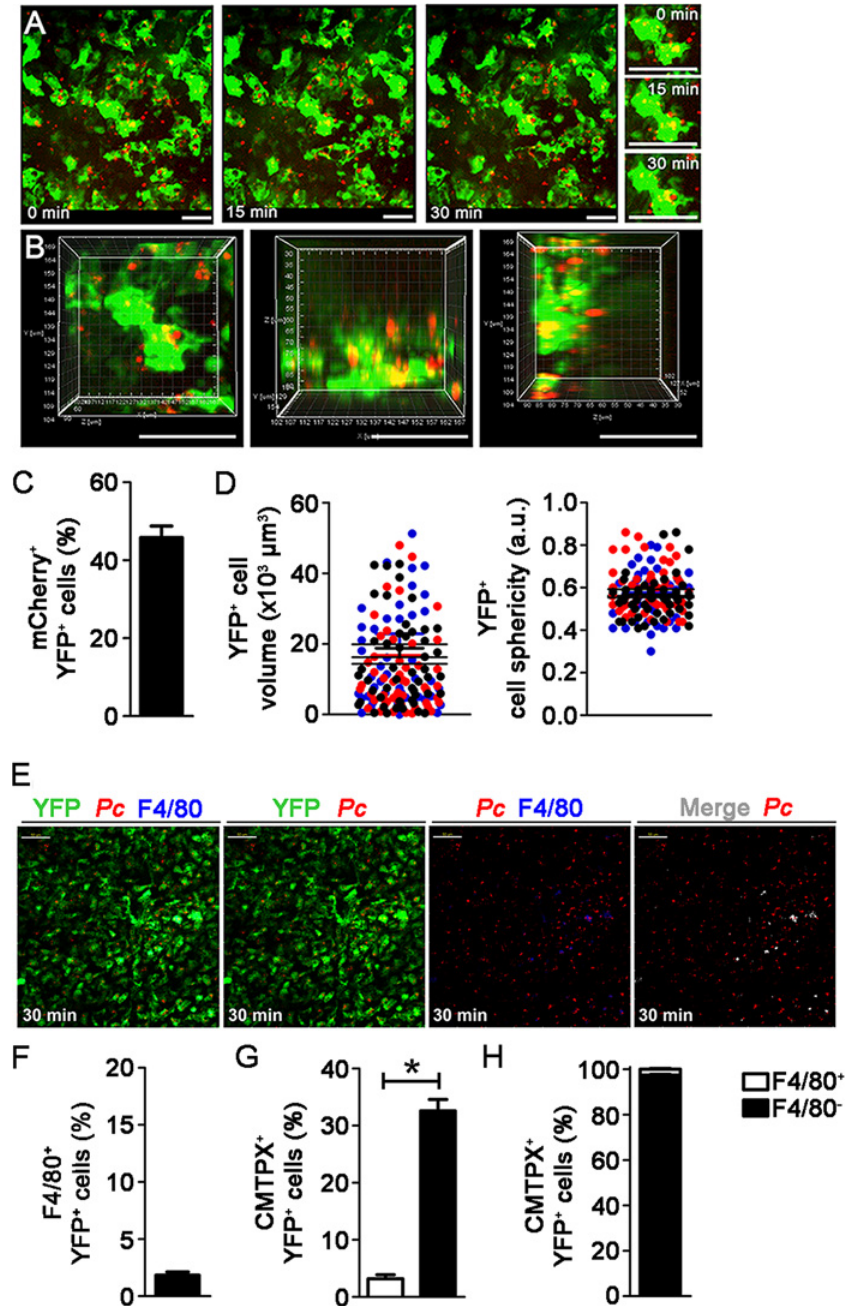
Figure 5. In vivo analysis of iRBC uptake by subcapsular RP DCs during pre-crisis. (A-D) B6.CD11c- YFP mice were i.p. infected with 1 × 10 6 mCherry- Pc iRBCs. Spleens were analyzed by CIVM after five days, at a time of day when mature parasite stages predominated. (A) Serial snapshots show the subcapsular RP and, in the right panel, a detailed image of a YFP + cell (green) upon phagocytosis of an mCherry- Pc iRBC (red). (B) CIVM 3D animation shows the presence of mCherry- Pc iRBC remnants (yellow spots of merged mCherry/YFP-3D signal) inside the YFP + cells. (C) Percentage of mCherry + cells in the YFP + cell population is shown (mean ± SEM). (D) YFP + cell volume and sphericity are shown. Black, red and blue dots are from three different experiments. Horizontal lines represent mean values and SEM. (E - H) B6.CD11c-YFP mice were i.p. infected with 1 × 10 6 Pc iRBCs. At five days p.i., mice were i.v. infected with 1 × 10 8 mature CMTPX- Pc iRBCs. After 15 min, mice were injected i.v. with a fluorescent anti-F4/80 mAb and the spleens were analyzed by CIVM. (E) Snapshots taken 30 min later show YFP + cells (green), iRBCs (red), F4/80 + cells